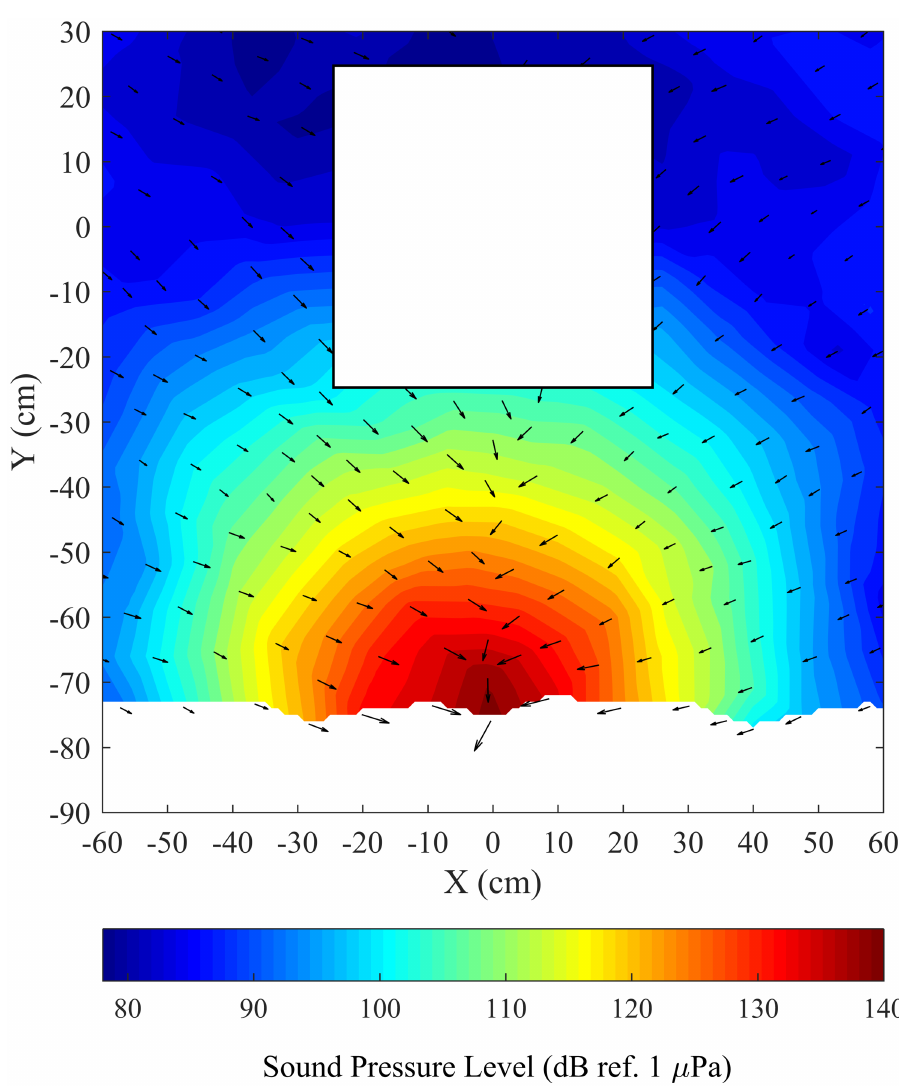
Fig 3. Plan view of sound pressure level in dB (ref 1 μ Pa) at 2000 Hz in the enclosure at a depth of 9 cm from the tank bottom with particle acceleration vectorsin xy -plane. Particle acceleration magnitudeis calculatedusing only the acceleration in the x - and y -directions. The speaker was hiddenbehinda plastic enclosureand locatedat 0 cm on the X-axis, with the center of the projector face 15 cm from the tank bottom. Contoursdo not extend to 90 cm becauseacoustic instrumentation could not be placedcloser to the plastic enclosure. sound pressure signal was sampled at 44.1 kHz and fed through a TASCAM US-122mkII (TASCAM, CA, USA) audio interface, digitized, and stored on a windows-based computer. The accelerometer was neutrally buoyant because it had been embedded in an extruded poly- styrene foam enclosure. The acoustic particle acceleration signal was conditioned using a PCB 482C05 conditioner and fed through a USB-1208FS-Plus data acquisition board (Measure- ment Computing, MA, USA) sampling each channel at 16 kHz. At each location, a 10 s sample was split into 10 signal ensembles and averaged. Data acquisition hardware was controlled by a custom graphical user interface operating in Matlab, which was also used to analyze and trans- form the pressure and particle acceleration waveforms into the frequency domain.